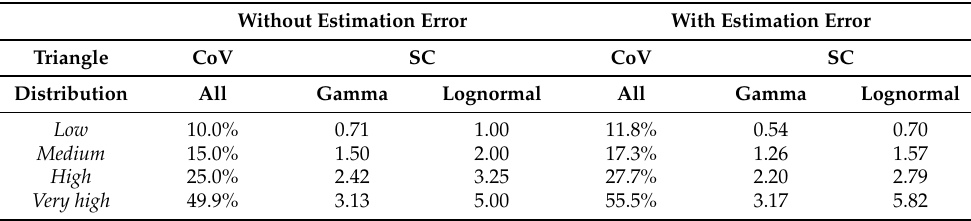
Table 1. CoV and SC measures of the outstanding loss from the ultimate perspective—the case without and with the estimation